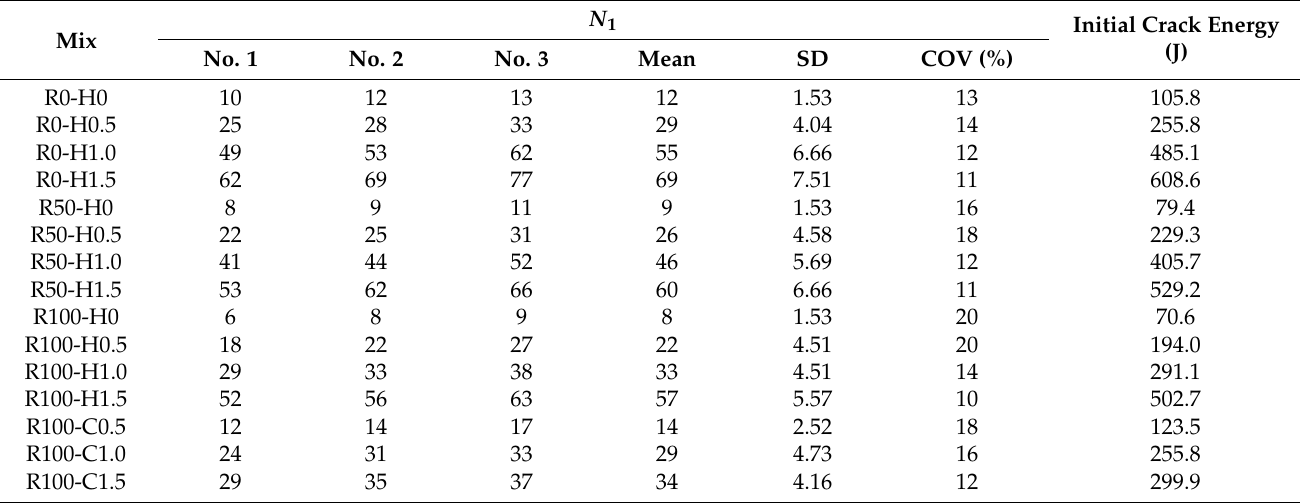
Table 6. The impact resistance of initial crack for steel fiber-reinforced